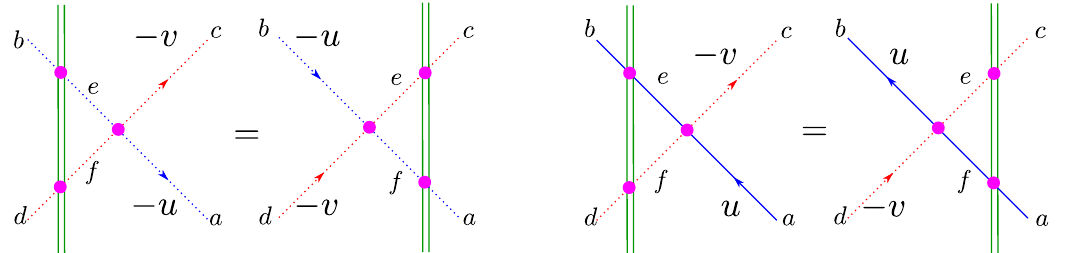
Figure 7. Additional Yang-Baxter equations, which follow from (5.5), but look a slightly differently